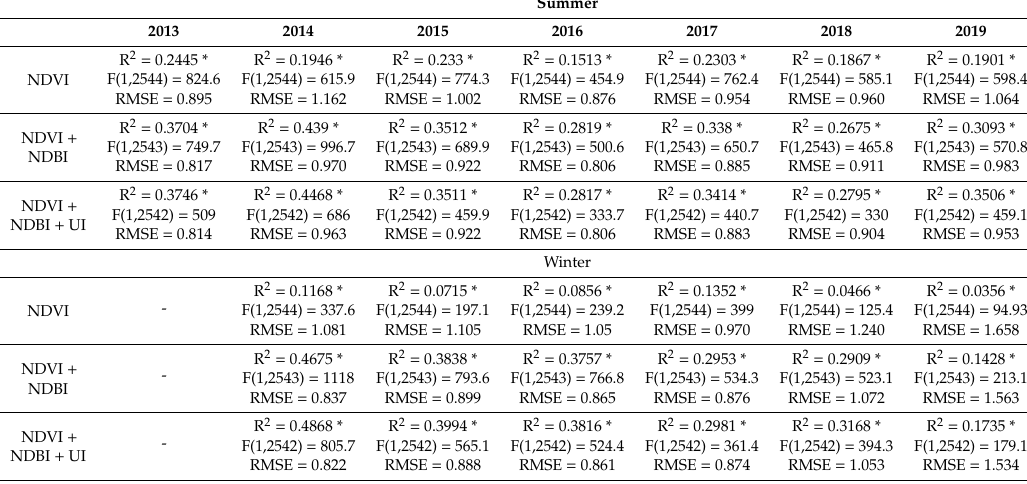
Table 2. Multiple regression analysis to estimate the potential of the three examined spectral indices (NDVI, NDBI, and UI), to predict LST in the summer and the winter seasons of 2013–2019.